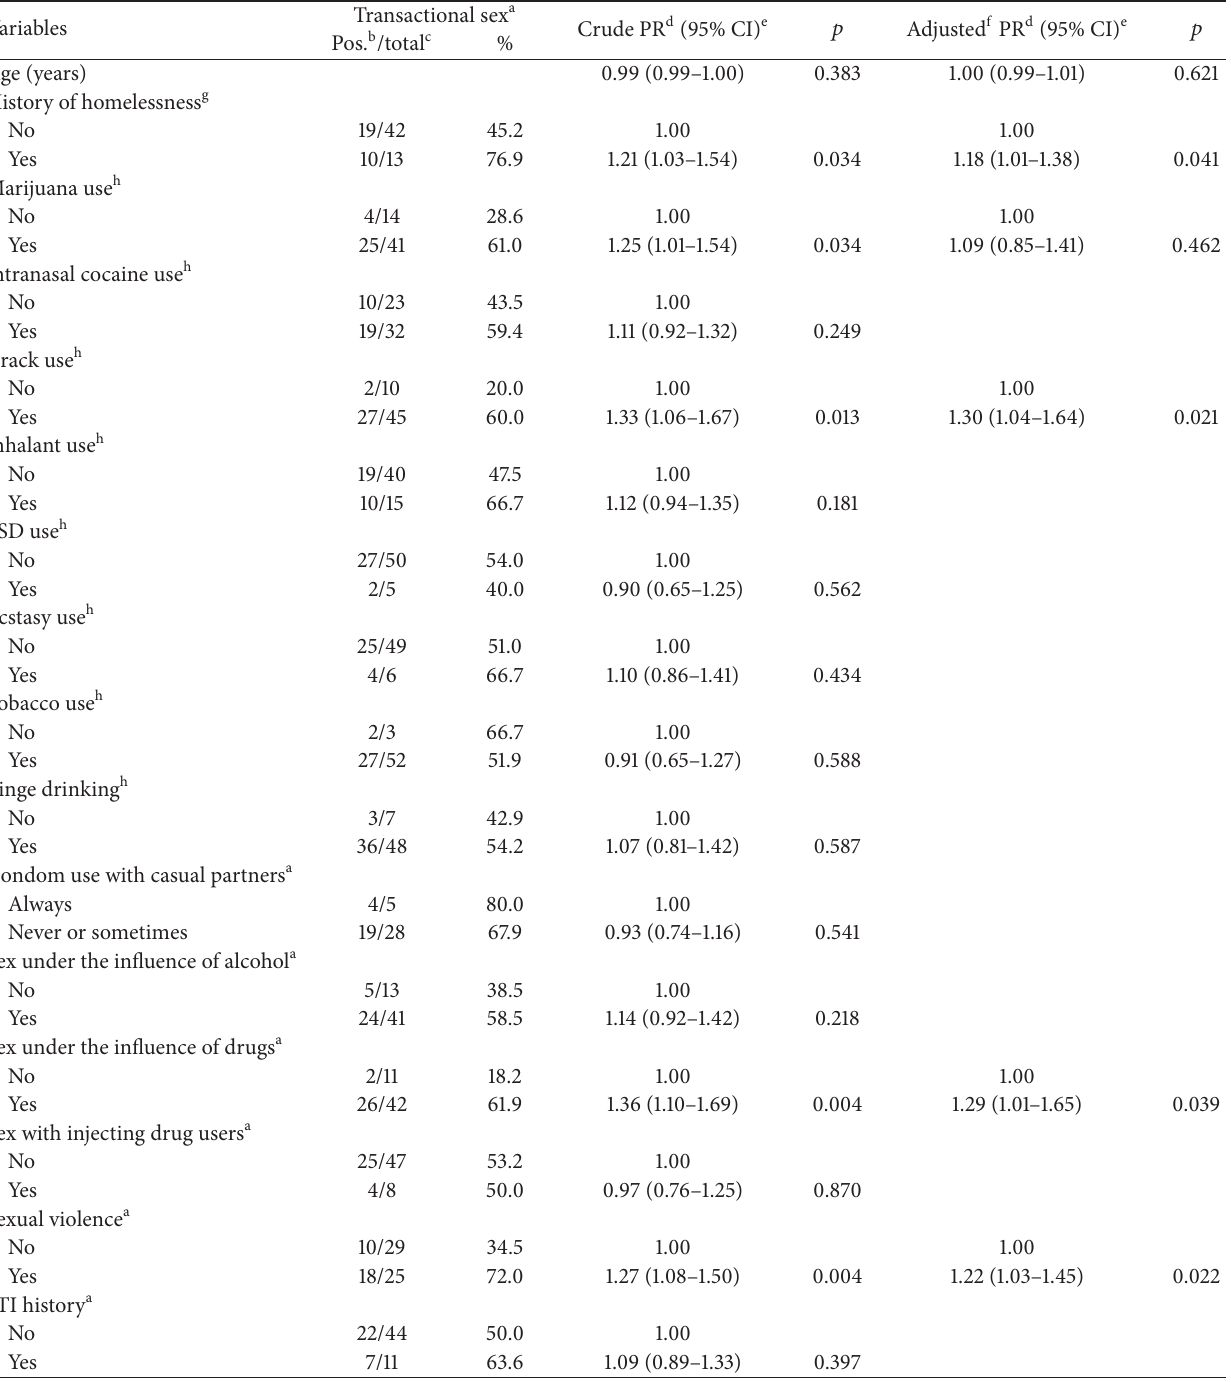
Table 2: Prevalence and risk factors for transactional sex among female noninjecting illicit drug